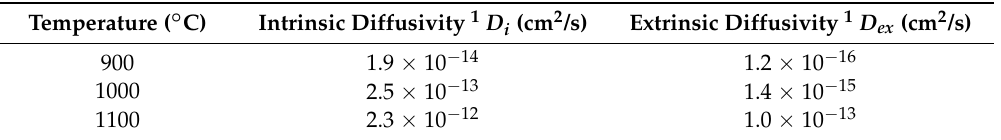
Table 3. D i and D ex of aluminum in